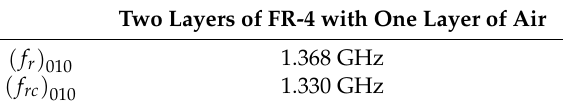
Table 4. Frequency of resonance.